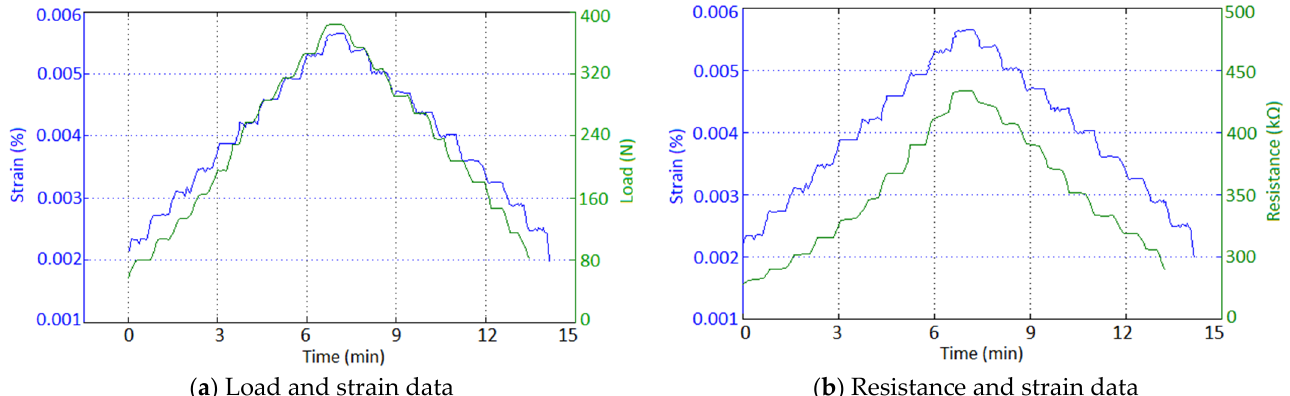
Figure 7. Load-strain and resistance-strain behavior of strain sensor for loading and unloading test.